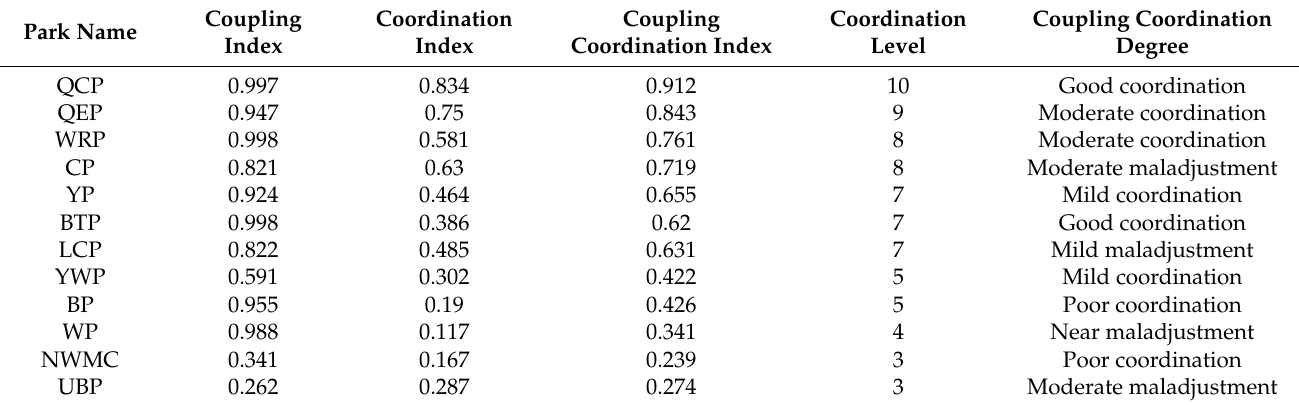
Table 12. Spatial–behavioral dimension coupling coordination